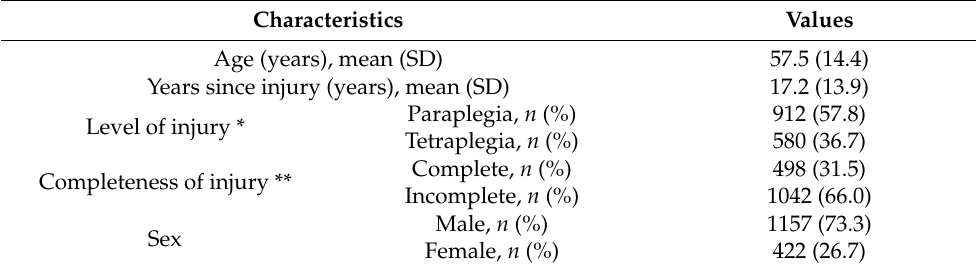
Table 1. The demographics for the sample of 1579